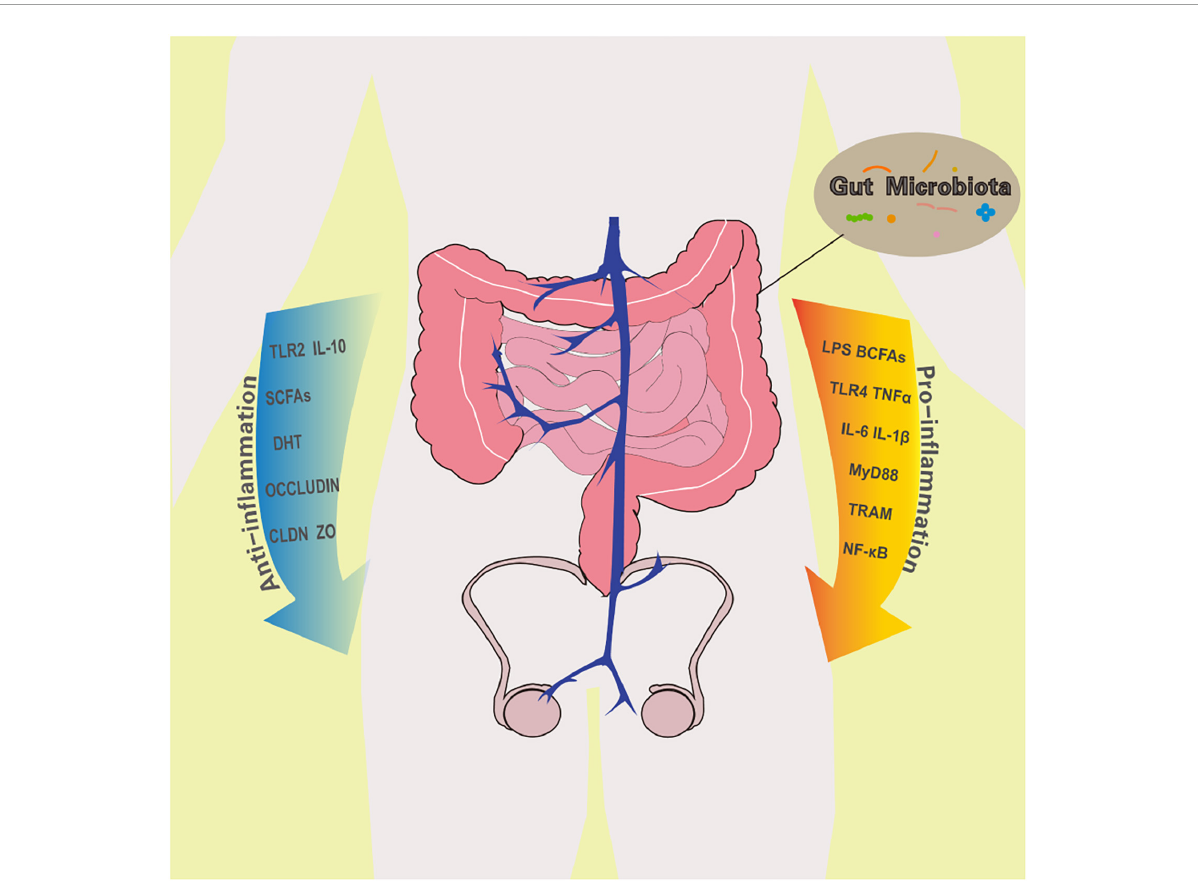
FIGURE2 The effect of gut microbiota on testes immune privileged microenvironment. A healthy GM promotes anti-inflammatory cells and factors. However, when abnormal bacteria multiply in large numbers, they increase the concentration of pro-inflammatory molecules in the intestine and body fluids. Both positive and negative changes in GM affect the status of the testicular immune microenvironment. TLR2, Toll-like receptor 2; IL-10, Interleukin-10; SCFAs, short chain fatty acids; DHT, dihydrotestosterone; CLDN, claudins; ZO, Zona occludens; LPS, lipopolysaccharide; BCFAs, branched chain fatty acids; TLR4, Toll-like receptor 4; TNF α , tumor necrosis factor α ; IL-6, Interleukin-6; IL-1 β , Interleukin-1 β ; MyD88, myeloid differentiation factor 88; TRAM, translocation associated membrane protein; NF- κ B: nuclear factor kappa